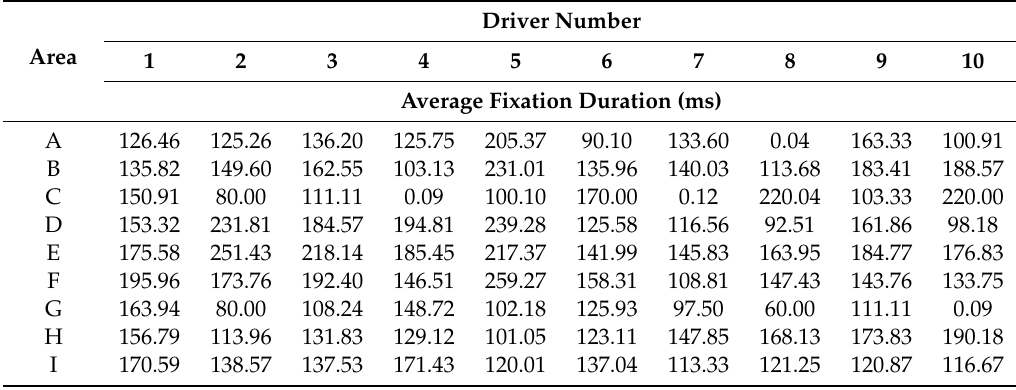
Table 4. Statistics of driver fixation duration.